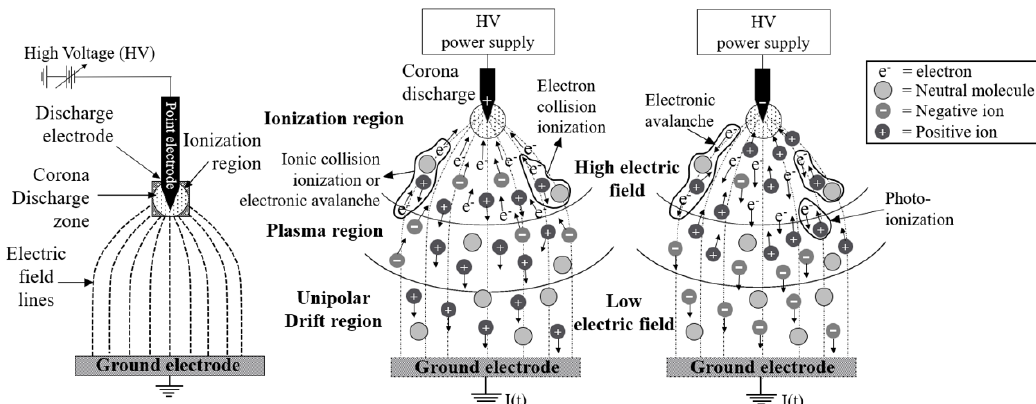
Figure 4. Schematic diagram of the discharge between the point and plate electrodes under applied high electrical voltage.